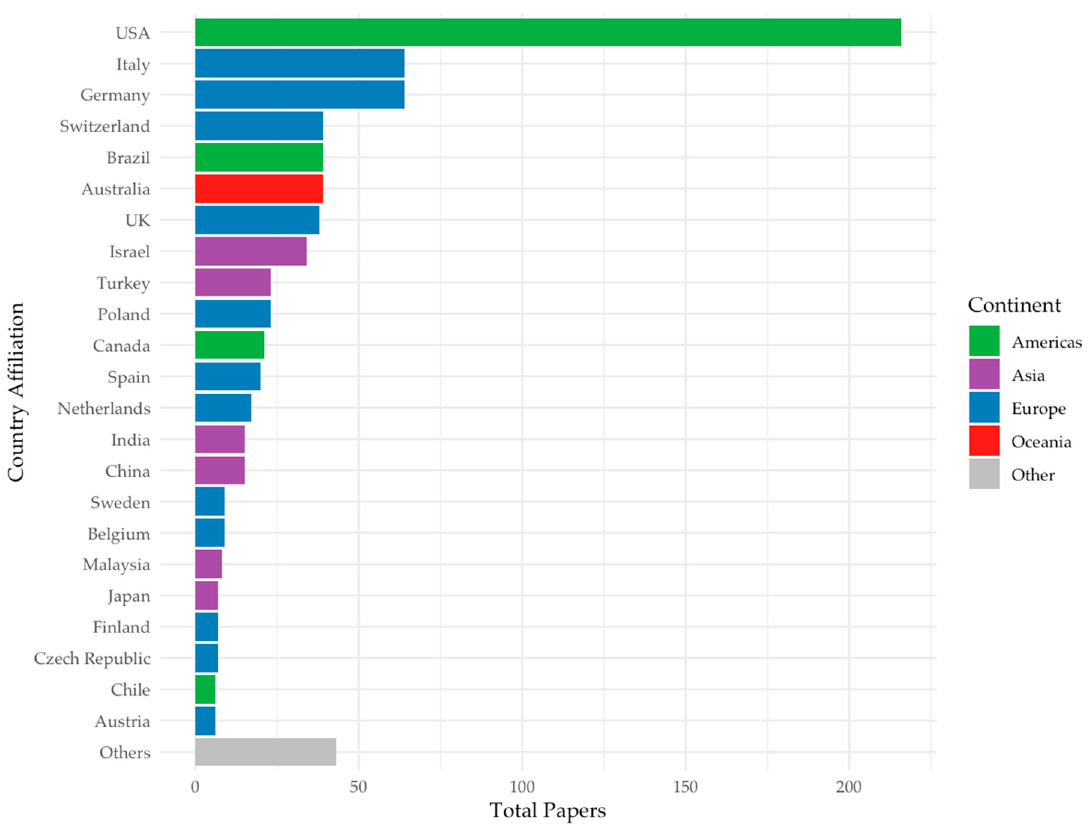
(cid:35) the number of Open Access documents.